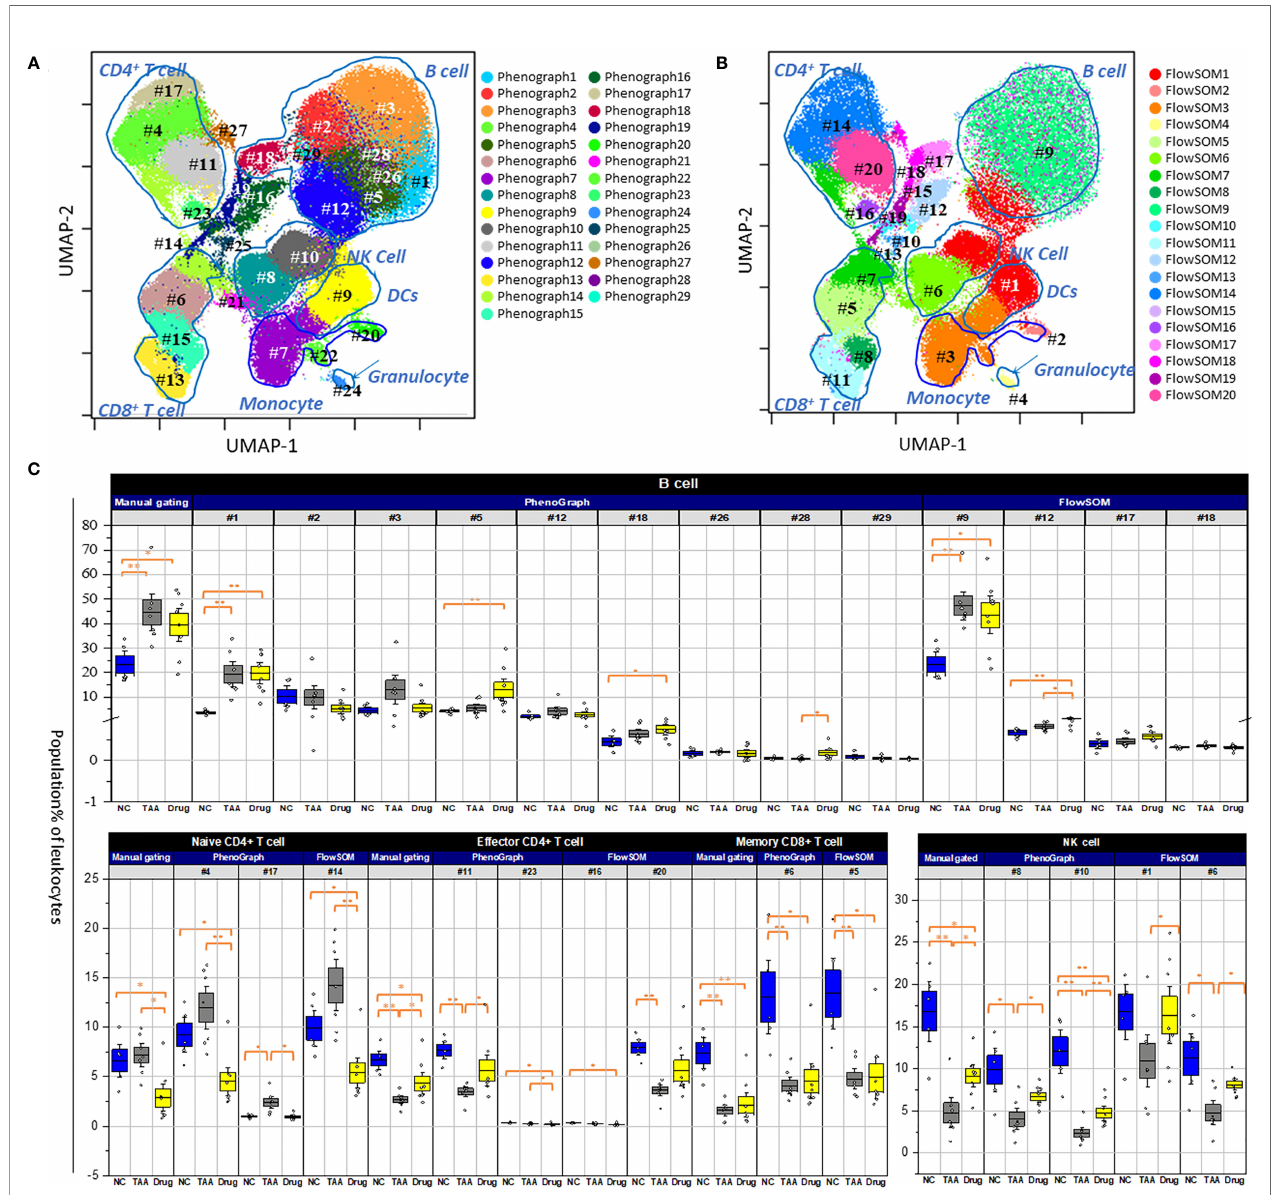
FIGURE 4 | Population abundance of manual gating. (A) PhenoGraph clusters analysis of manual gated leukocytes population. (B) FlowSOM clusters analysis of manual gated leukocytes population. Both overlaid on uniform manifold approximation and projection (UMAP). The numbering with # denoted individual population clusters. (C) Comparison of manually gated cell types for NC, TAA, and Drug groups represented in boxplots graph. The statistical signi fi cant differences considered 0.01 < p and < 0.05, 0.001 < p have been annotated as * and **